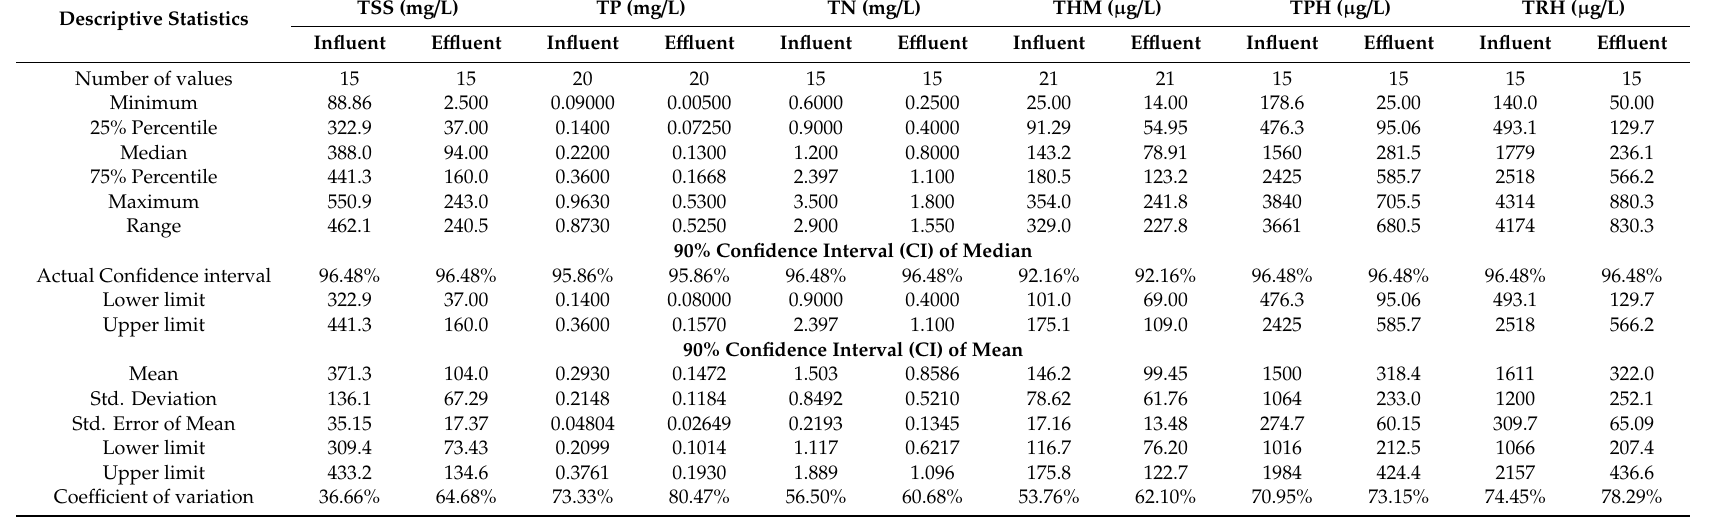
Table 4. Arithmetic summary statistics of the data